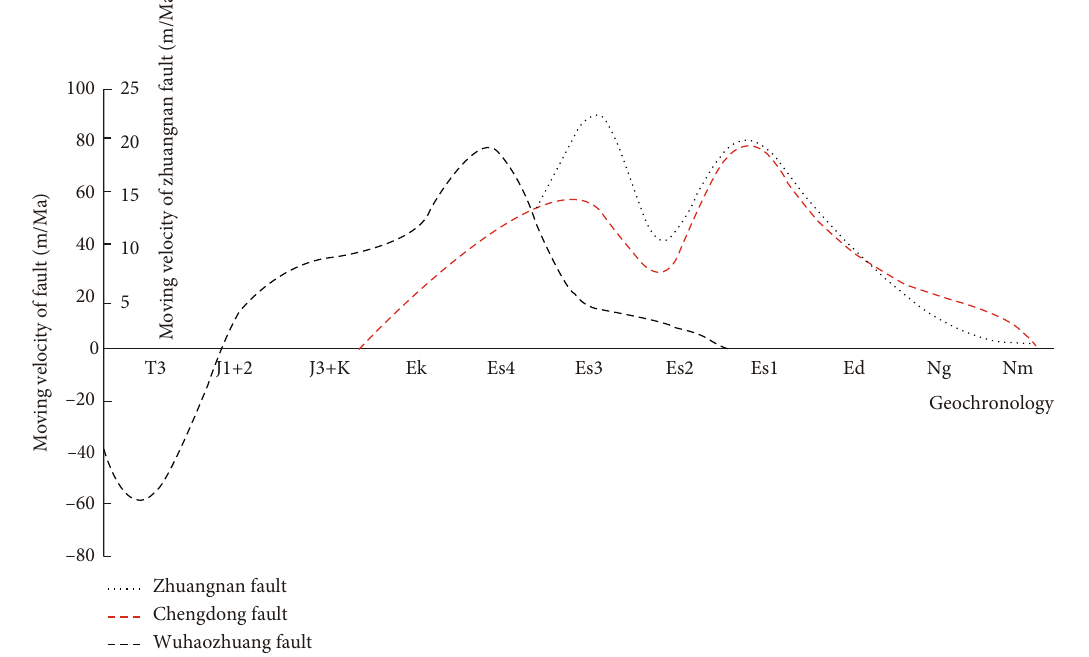
Figure 12: Activity of Zhuangnan fault, Chengnan fault, and Wuhaozhuang